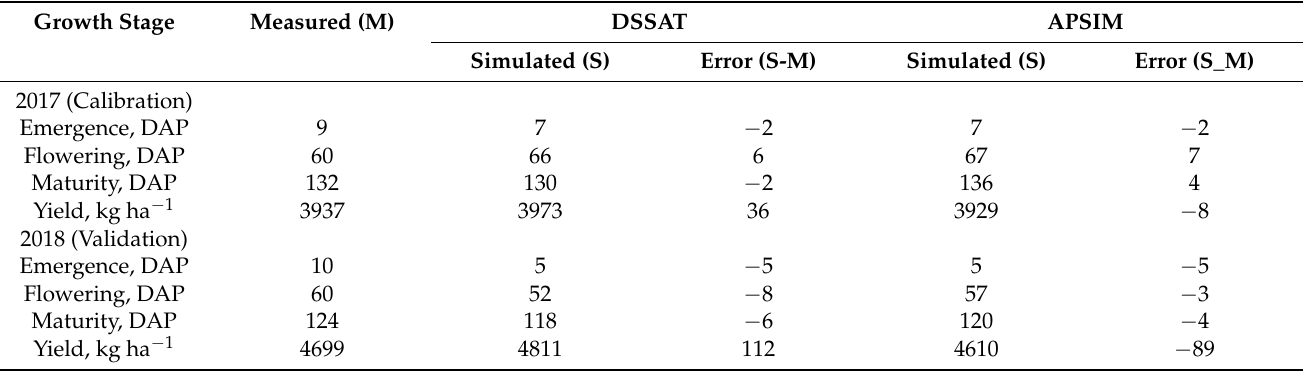
Table 5. Measured and simulated seedling emergence, flowering, number of days to physiological maturity, and yield of cotton in the evapotranspiration-eddy covariance-experiments in